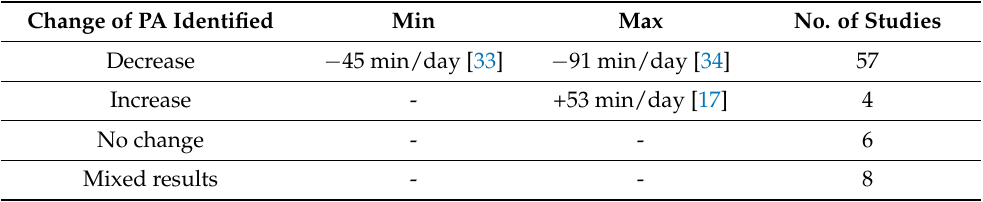
Table 1. Changes in physical activity (PA) of children and adolescents during the COVID-19 pandemic.